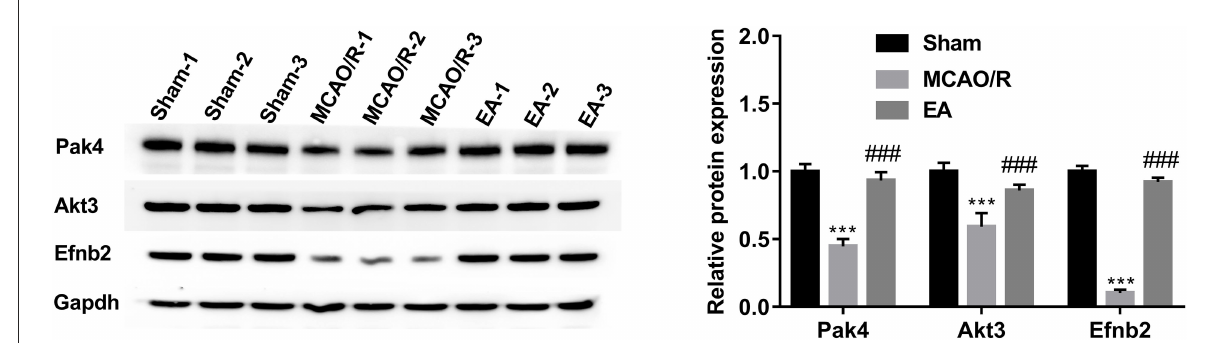
FIGURE7 Western blot validation of Pak4, Akt3, and Efnb2 protein levels in hippocampal tissues of sham, MCAO/R, and EA rats. Protein levels of Pak4, Akt3, and Efnb2 were measured by western blot assay in hippocampal tissues of sham ( n = 3), MCAO/R ( n = 3), and EA ( n = 3) rats. Compared with the sham group, *** P < 0.001; compared with the MCAO/R group, ### P < 0.001.